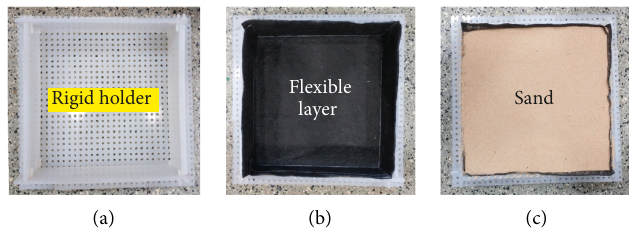
Figure 2: Rigid full contact mold: (a) empty mold, (b) covered with geotextile in the bottom, and (c) filled with sand.